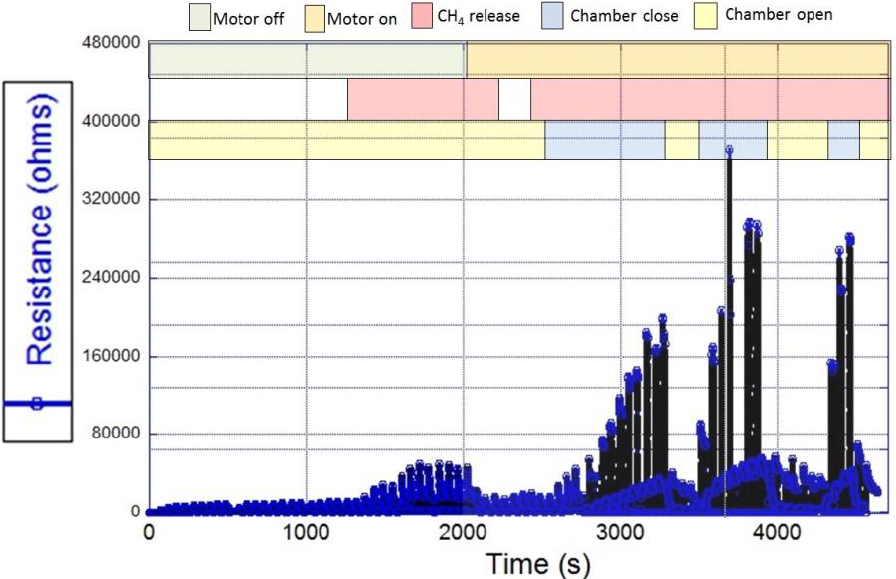
Figure 10. Bench testing of the CH 4 sensing system with a pollutant emission